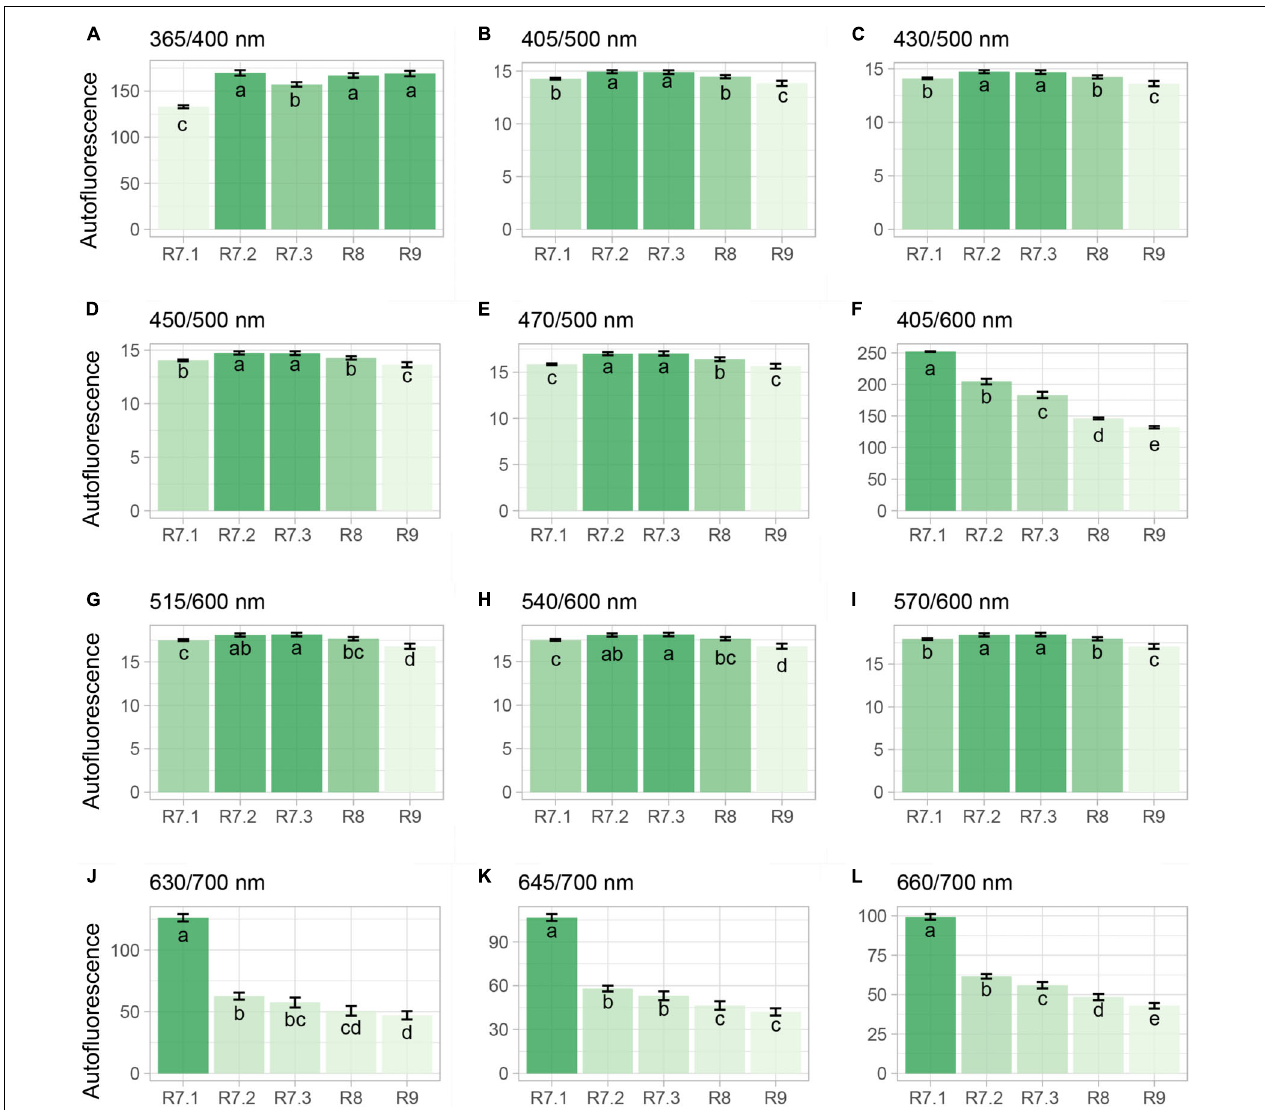
FIGURE 4 | Autofluorescence-spectral data from different excitation/emission combinations in soybean seeds at different seed maturation stages. Each bar represents the mean of four replicates of 25 seeds ± standard deviation. Different letters indicate significant difference ( α = 0.05) by Tukey test ( n =